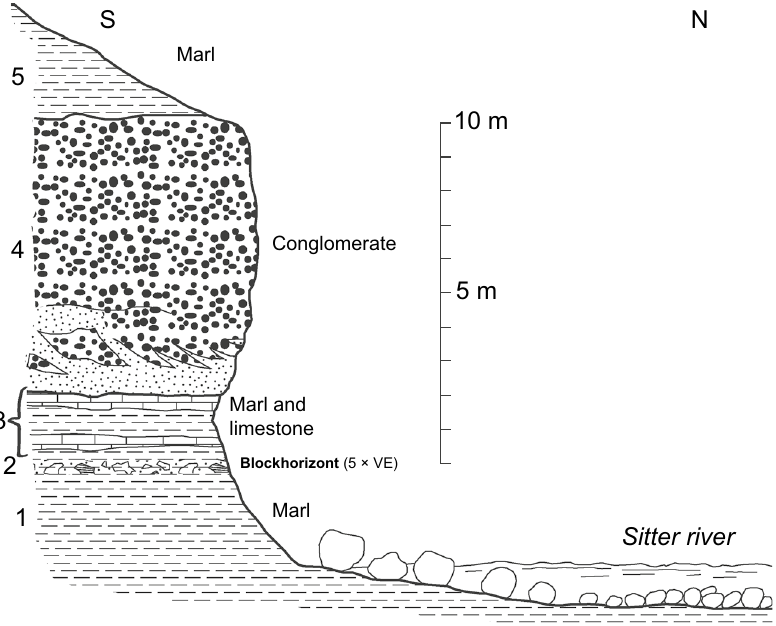
Figure 2. Stratigraphic section of the Bernhardzell Blockhorizont site (this study). (1) Marl, (2) Blockhorizont, (3) Marl and marl with thin layers of limestone, (4) Conglomerate of the Hörnli alluvial fan, and (5) Marl. All units shown here belong to the Upper Freshwater Molasse of the North Alpine Foreland Basin. Thickness of Blockhorizont exaggerated (×5) for visibility. After Ref. 18 .